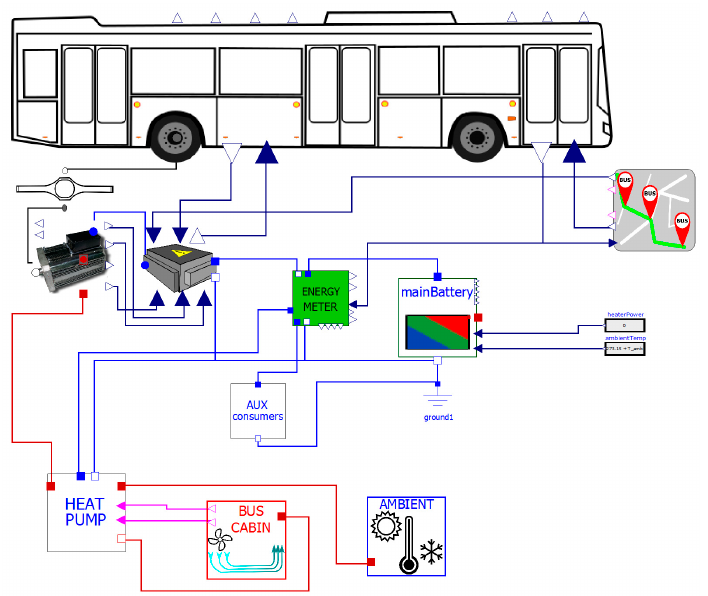
Figure 5. Implementation of the electric bus in OpenModelica.